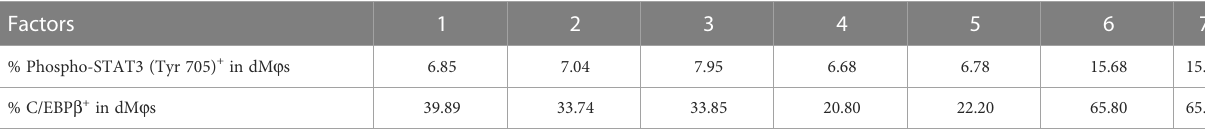
TABLE 1 The data for correlation analysis in Figure 4D .